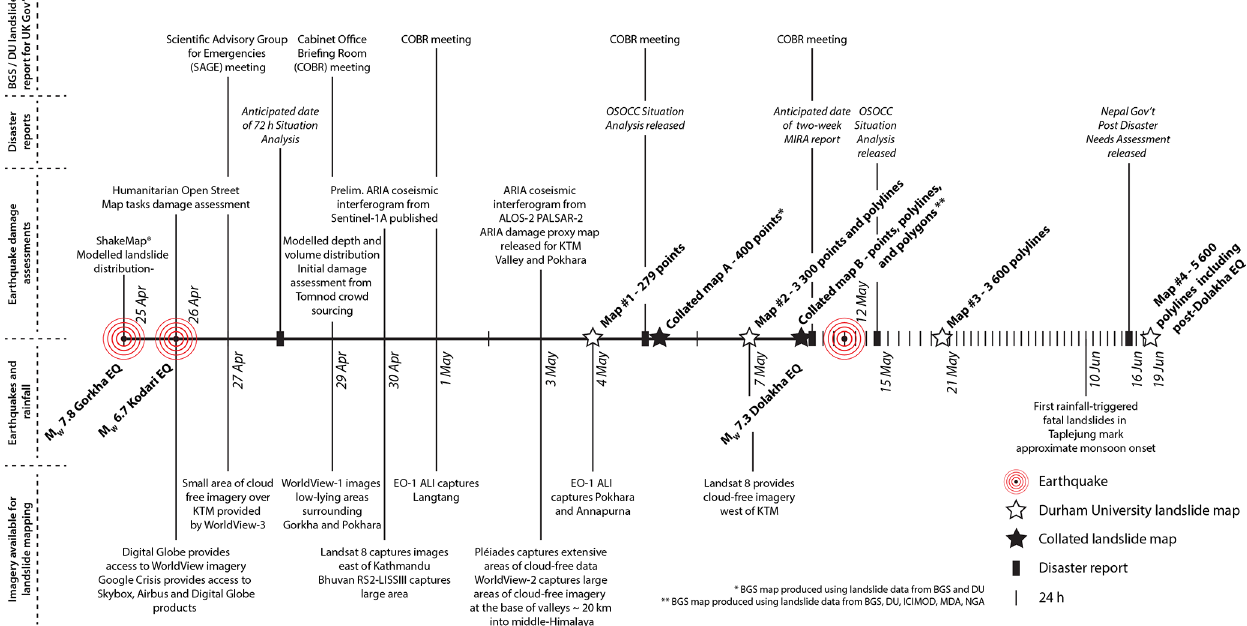
Figure 2. Timeline of image acquisition, mapping, disaster reports, and other earthquake damage assessments from 25 April 2015. Earth- quake timing is also added alongside the approximate onset of the monsoon on 10 June (46 days after the Gorkha earthquake). The timing of the OCHA On-site Operations Coordination Centre (OSOCC) Situation Analysis reports and the Nepal Government’s Post Disaster Needs Assessment (PDNA) is added alongside the proposed timings of the Situation Analysis and MIRA report as defined by IASC (2015). No MIRA report was created following the Nepal earthquakes due to logistical difficulties in organizing its creation and physical access con- straints (ECHO, 2015). The timeline is nonlinear, with each vertical line representing 1